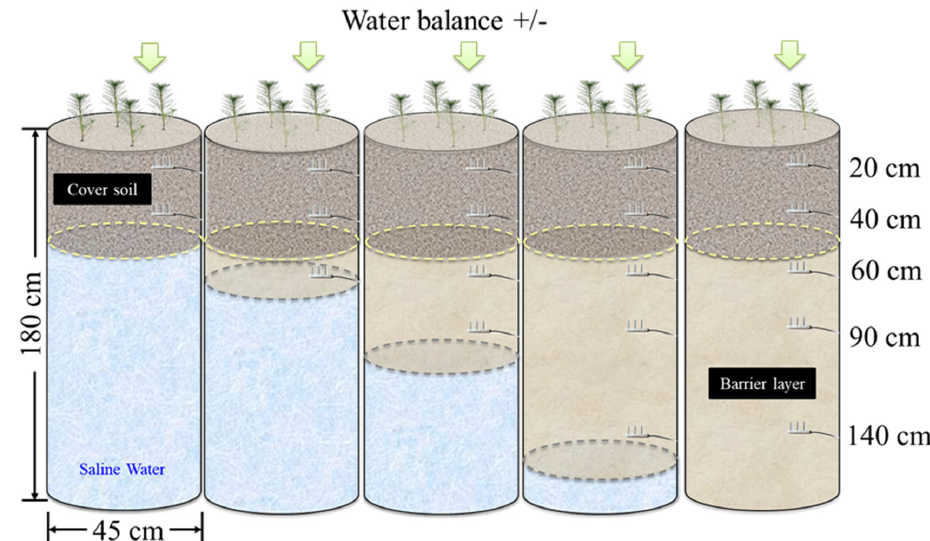
Figure 1. Column design with treatments of barrier material, barrier thickness, and water balance. The positions of GS3 sensors are illustrated by the symbol . Table 1. Initial soil properties in the column experiment.